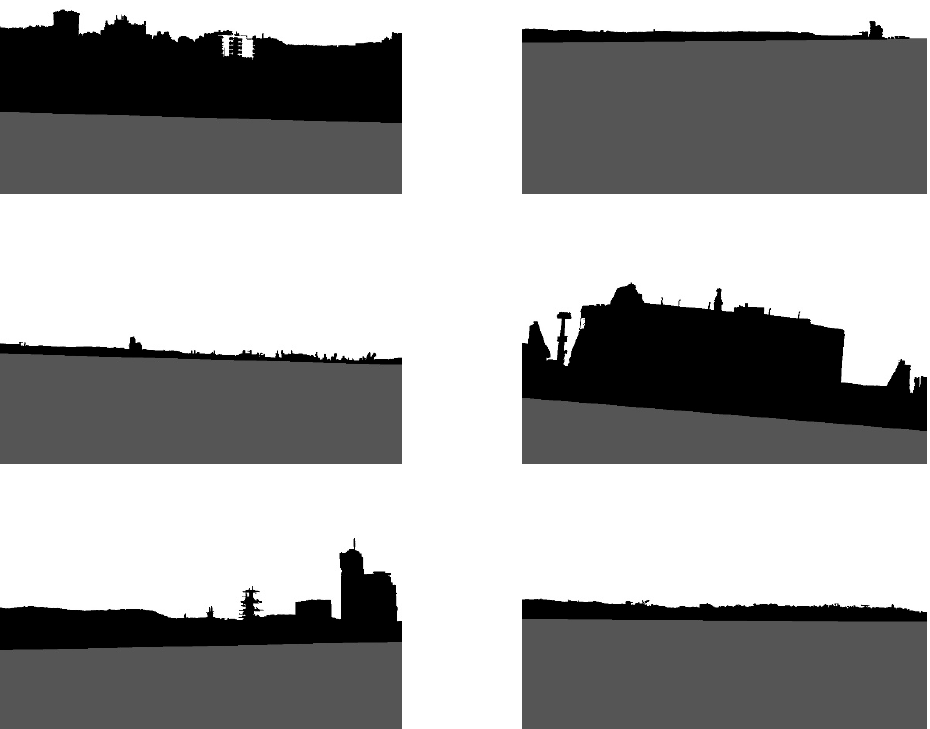
Figure 14. Results of land segmentation.